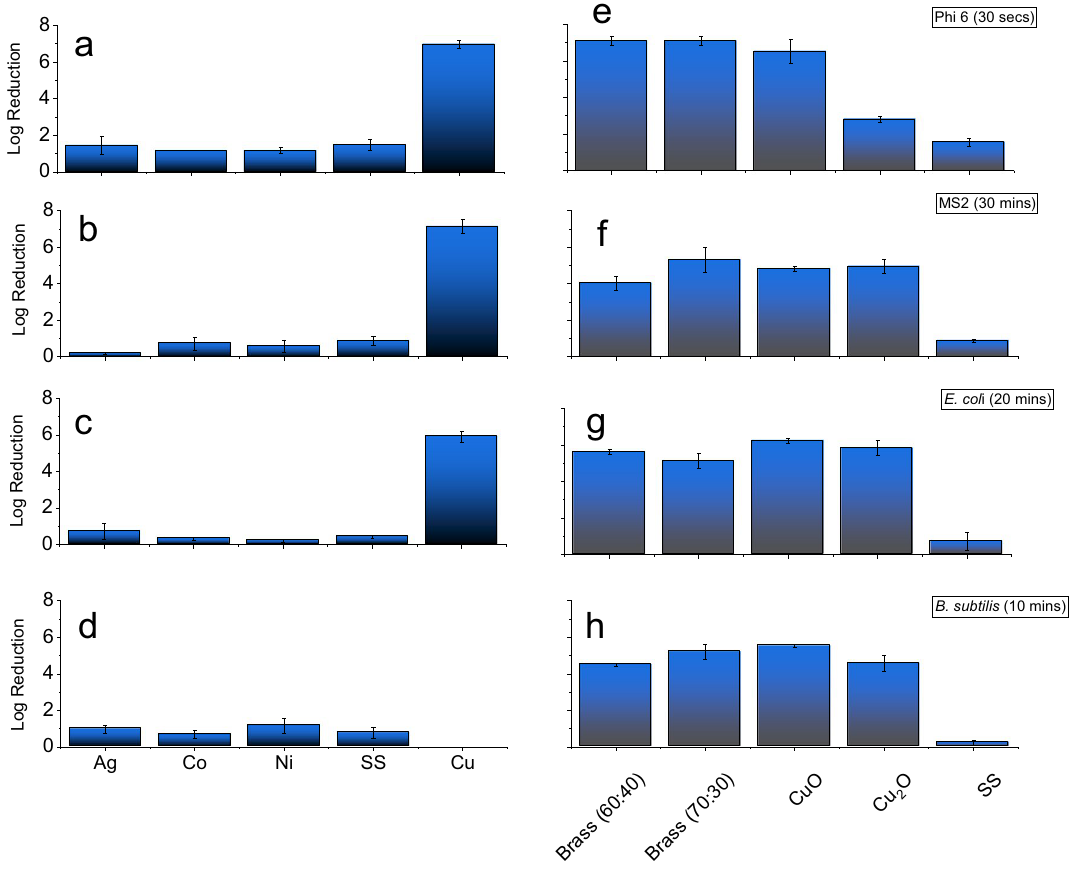
Figure 4. Antimicrobial activity of single component (left) and multicomponent (right) surfaces, tested on ( a , e ) Phi6, ( b , f ) MS2, ( c , g ) E. coli , and ( d , h ) B. subtilis . No B. subtilis was recovered on the metal